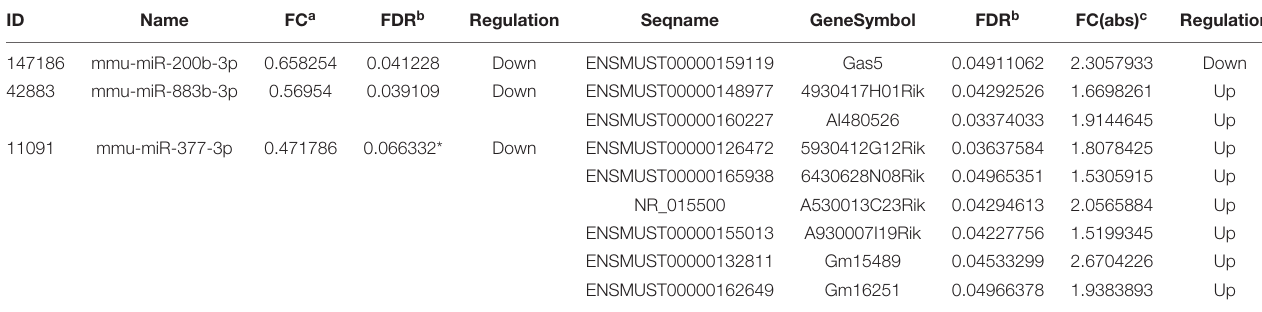
TABLE 2 | Differentially expressed miRNAs and their differentially expressed lncRNAs targets.